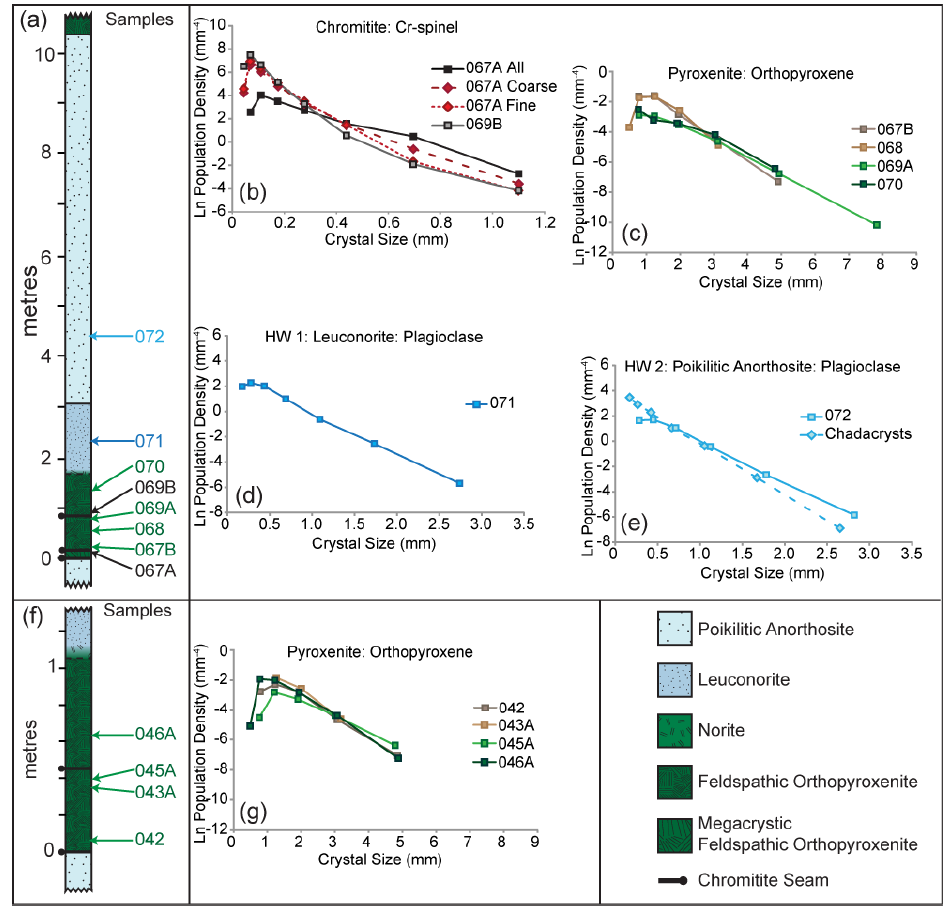
Figure 10. CSD plots for the Merensky Unit, divided according to rock type and mineral phase analysed. RPM type with stratigraphic column ( a ) indicating the vertical location of each sample with CSD plots for ( b ) chromitite, ( c ) feldspathic orthopyroxenite, ( d ) leuconorite, ( e ) poikilitic anorthosite; Marikana type with stratigraphic column ( f ) indicating the vertical location of each sample with CSD plot for ( g ) feldspathic orthopyroxenite. Note, plot scales vary but are constant for each mineral analysed.